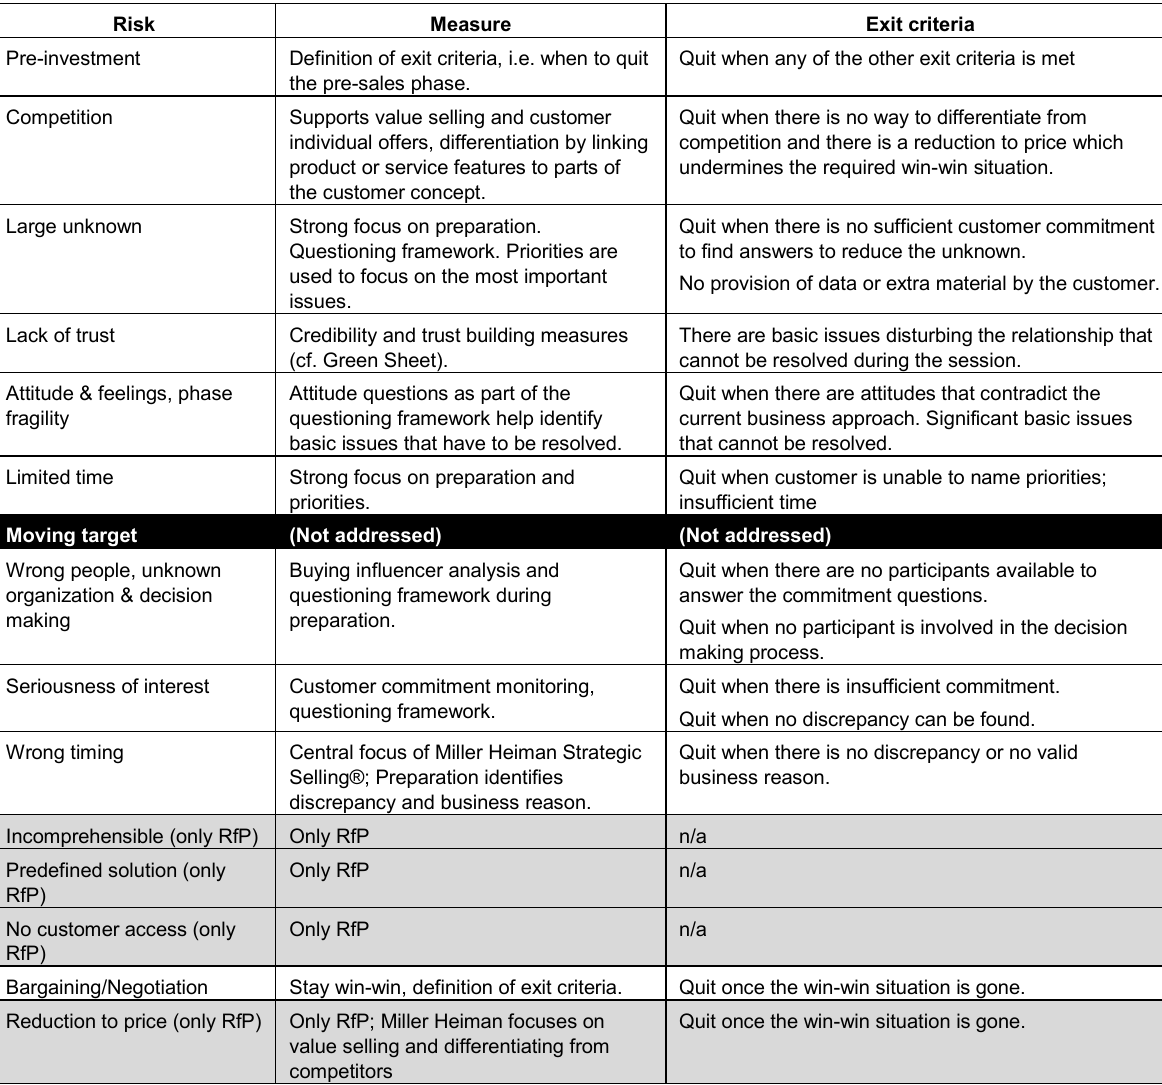
Table 2 . Pre-sales risks, their partial coverage by the Miller Heiman sales approach, and their exit